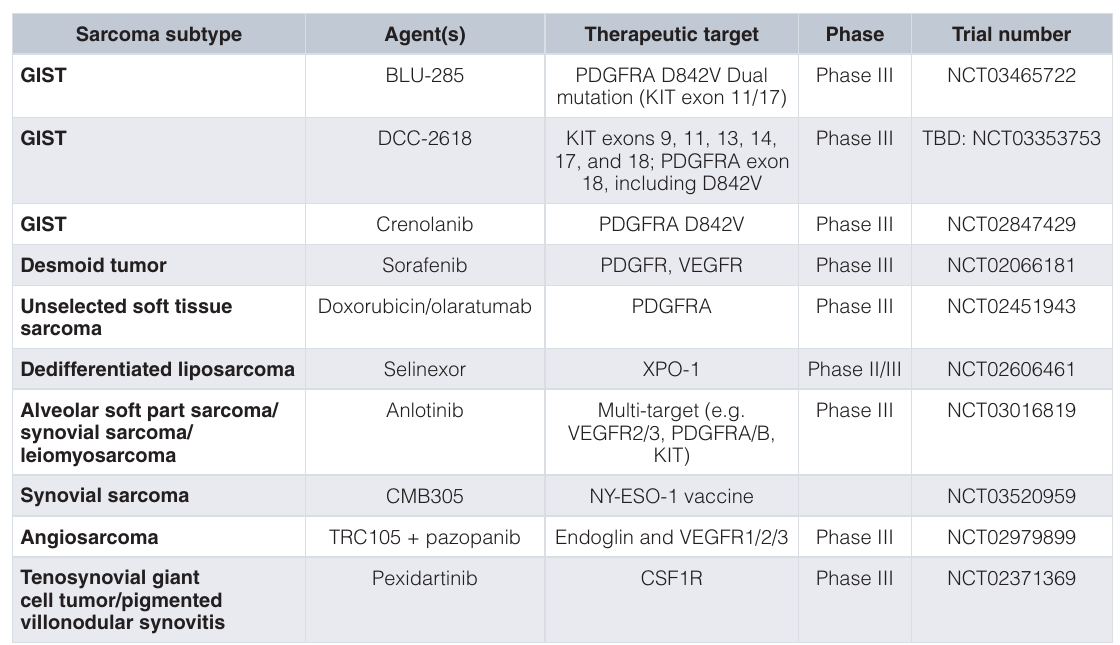
Table 1. Ongoing late-phase clinical trials in